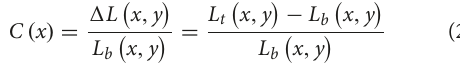
level, C ave represents the average value of the visibility level,